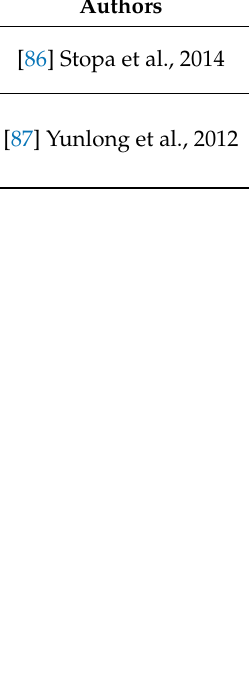
Table 3. Process model-based